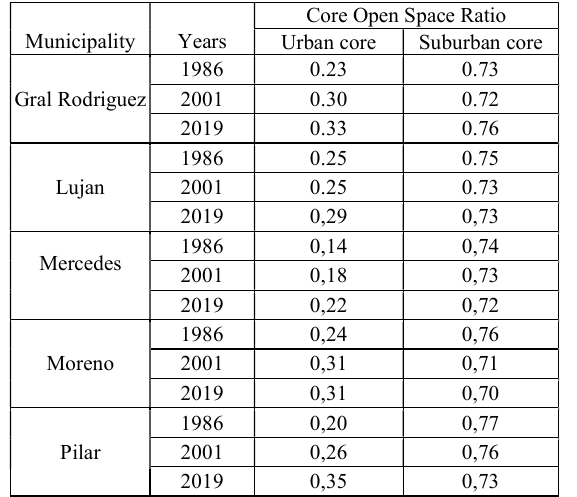
Table 2. Core Open Space Ratio in built-up areas The values indicate that the 1986 urban cores presented a core open space ratio smaller than the present ones. It means that the increase of impervious surface implies the variability of urban voids. In the cases of Pilar and Moreno, which are the municipalities that have formed more urban cores, also present the largest open spaces ratio (0.35 and 0.31, respectively). Their suburban cores, present an open space ratio higher than 70 percent along the time.